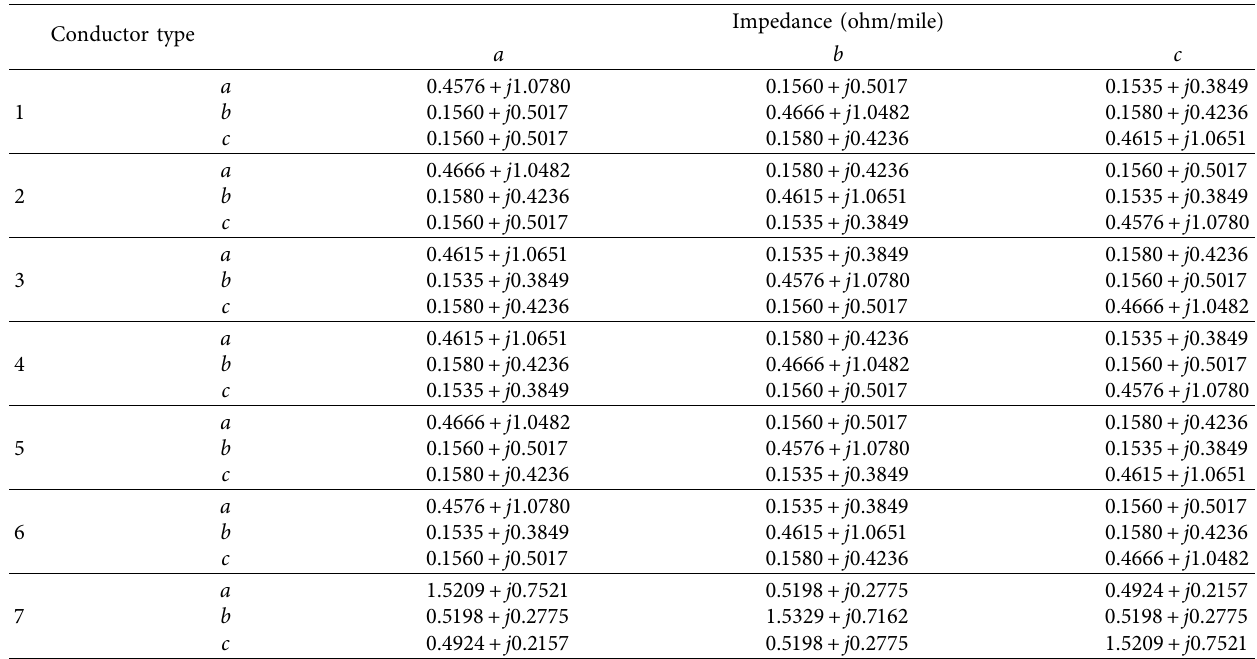
Table 7: Line impedance of 123-bus